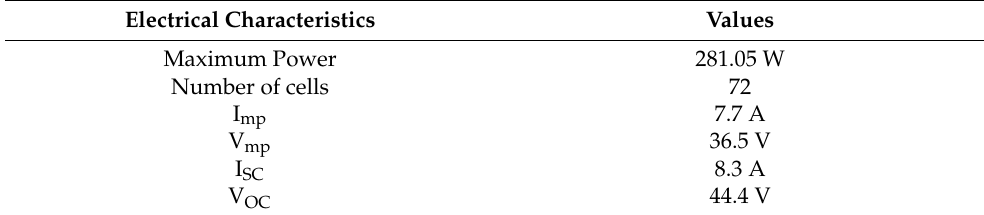
Table 1. Electrical characteristics of PV panel Hyundai Heavy Industries